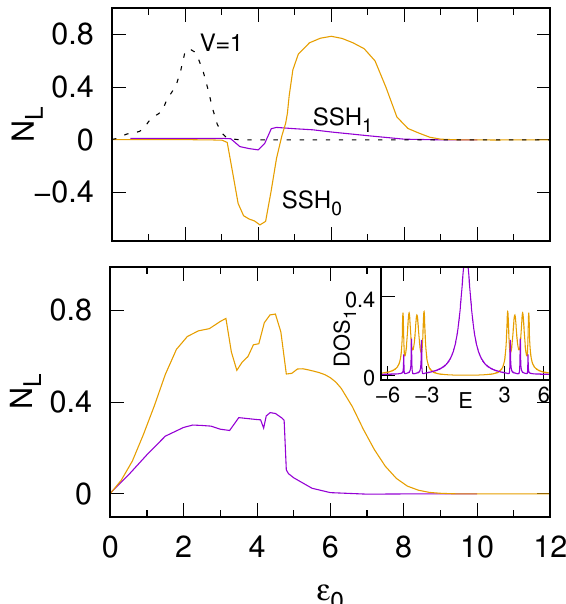
Figure 3. Charge pumped through the 8-atom SSH chain as a function of ε 0 for t x = 3. The upper (lower) panel corresponds to the one-Gaussian (two-Gaussian) perturbation. The broken line corresponds to the normal chain with V = 1. The other parameters are the same as in Figure 2. The inset in the bottom panel shows the local DOS at the first site of the SSH chain in the trivial (SSH 0 ) and nontrivial (SSH 1 )